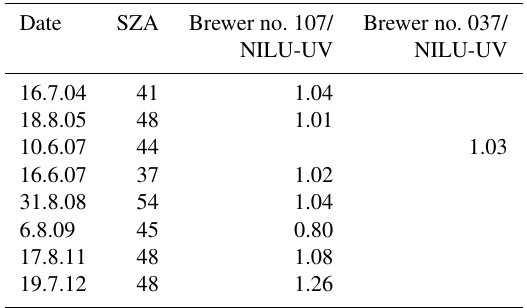
Table 1. The ratios of erythemally weighted UV dose rates between the reference NILU-UV and Brewer spectroradiometers no. 037 and no. 107 during 2004–2012. The date format is day.month.year (two digits).